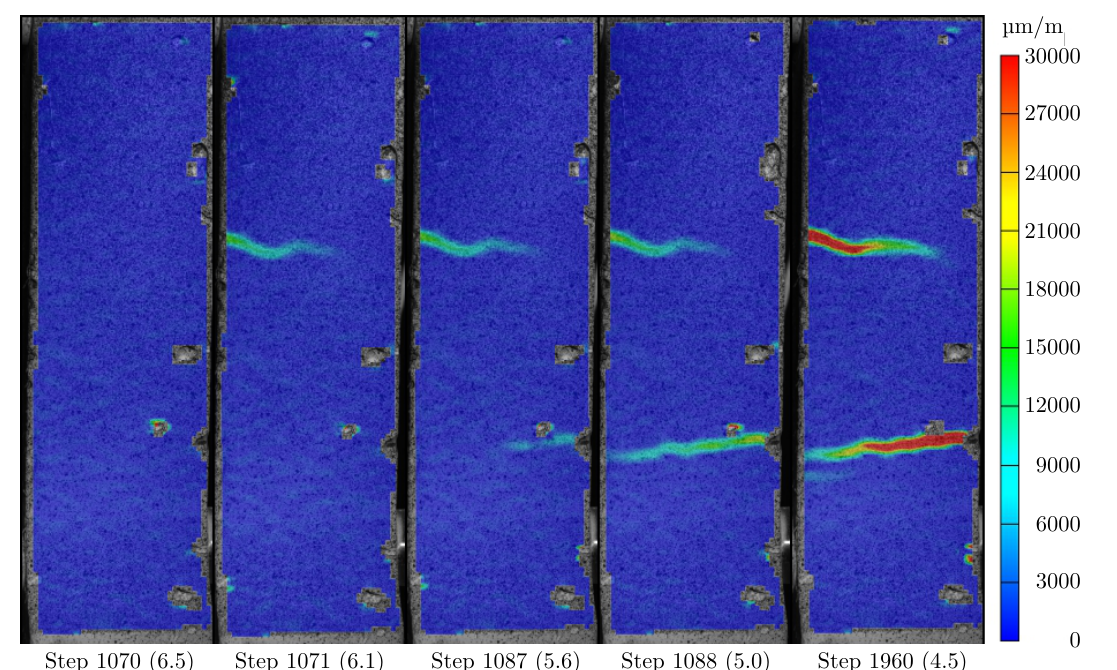
Figure 4. Strain distribution of sample FA5_2%_F1_3.